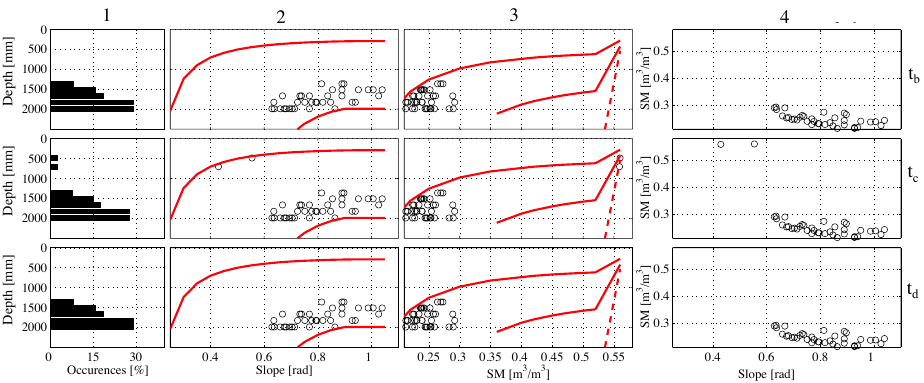
Fig. 10. Frequency distribution of failure depths (column 1), scatterplots of slope vs. depth (column 2) and SM vs. depth (column 3) for all failing elements at time steps increasing with rows ( t b , t c , t d ) with anisotropy equal to 300. The red lines designate the limits of the region of all possible instability cases. For column 2, the upper red line describes the worst conditions obtained from Eq. (3) at a fully saturated state of the most permeable soil (sandy loam), and the lower line is obtained from Eq. (3) at unsaturated conditions for the minimum value of soil moisture at which a failure occurs (0.29m 3 m − 3 ) ; for column 3, the red lines are obtained from Eq. (3) at fixed slope values by considering the steepest slope (63 ◦ , ∼ 1.1 rad, upper red line) and two gentler slopes (35 ◦ , ∼ 0.6rad, lower solid line; 23 ◦ , ∼ 0.4rad, dashed